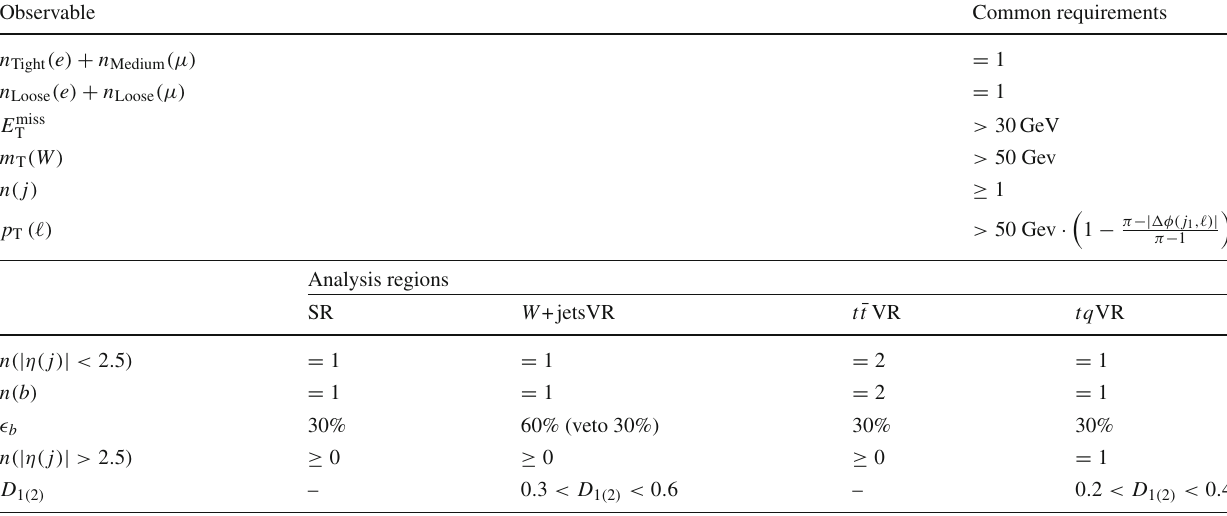
Table 1 Summary of selection requirements used to define the four analysis regions. The left column lists the observables on which the requirements are based. The first part of the table lists requirements whicharecommontoallfouranalysisregionsanddefinethebasicevent selectiondescribedinSect.4.2.Tightelectronsandmediummuonswere counted based on a p T threshold of 27GeV and they are a subset of the